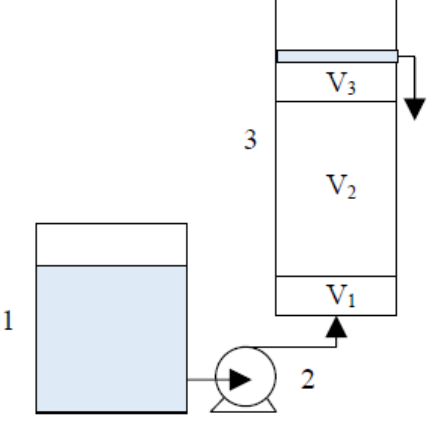
Figure 1. Column experimental setup: (1) Cr VI solution storage tank; (2) peristaltic pump; (3) column with V 1 (sand 1.2–2.0 mm, 5.0 cm 3 ), V 2 (reactive zone) and V 3 (sand 0.5–1.2 mm, 5.0 cm 3 ) layers. Three different systems were investigated: (1) Fe 0 + sand (1.2–2 mm), (2) Fe 0 only, and